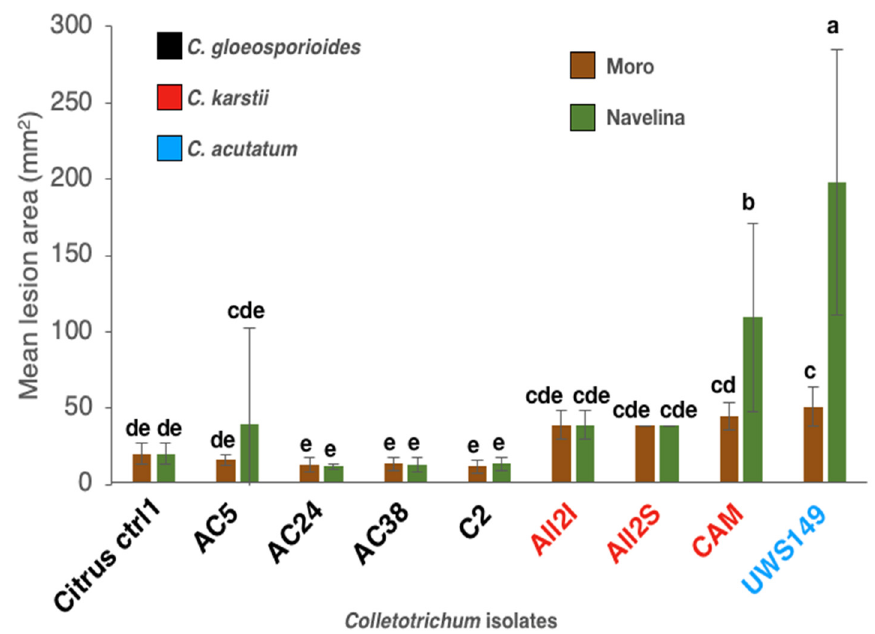
Figure 12. Mean area of 24 replicates (four leaves with six lesions each) of necrotic lesions (mm 2 )